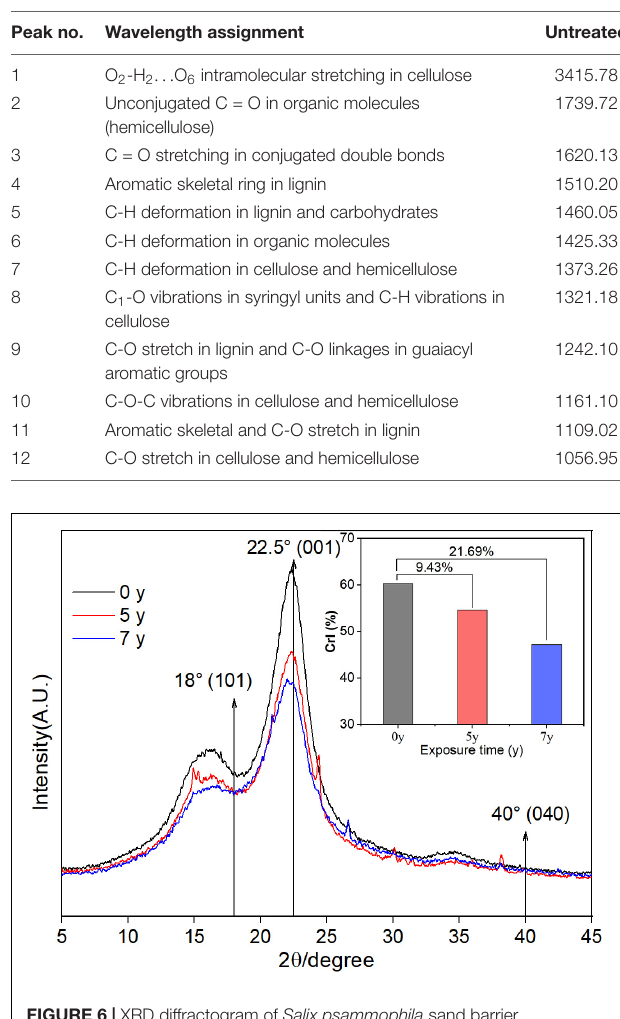
FIGURE 6 | XRD diffractogram of Salix psammophila sand